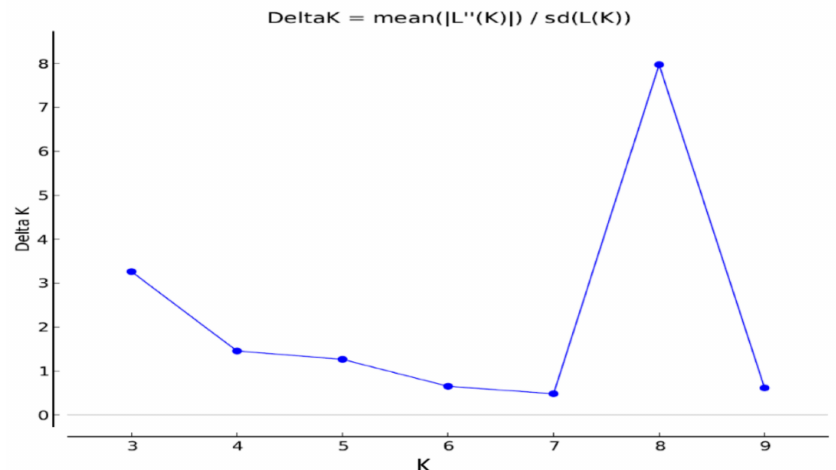
Figure 2. Estimation of population structure using LnP(D) derived ∆ K for determining the optimum number of subpopulations. The maximum value of delta K was found to be at K = 8, suggesting division of the entire population into eight subpopulations.